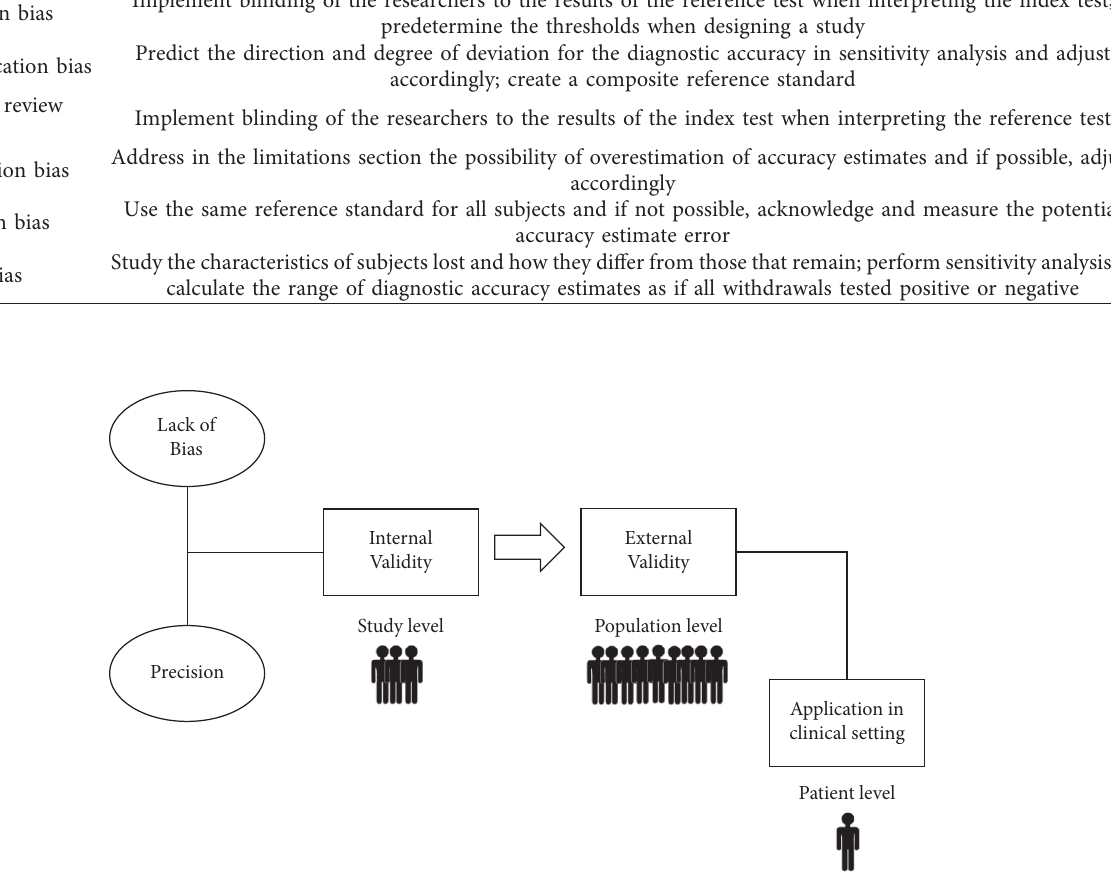
Figure 1: Internal and external validity. Precision and lack of bias dictate the internal validity of the study. External validity refers to the process of applying the study results from the study level to the population level. Radiologists can use these results in their own clinical practice for management of individual patients.